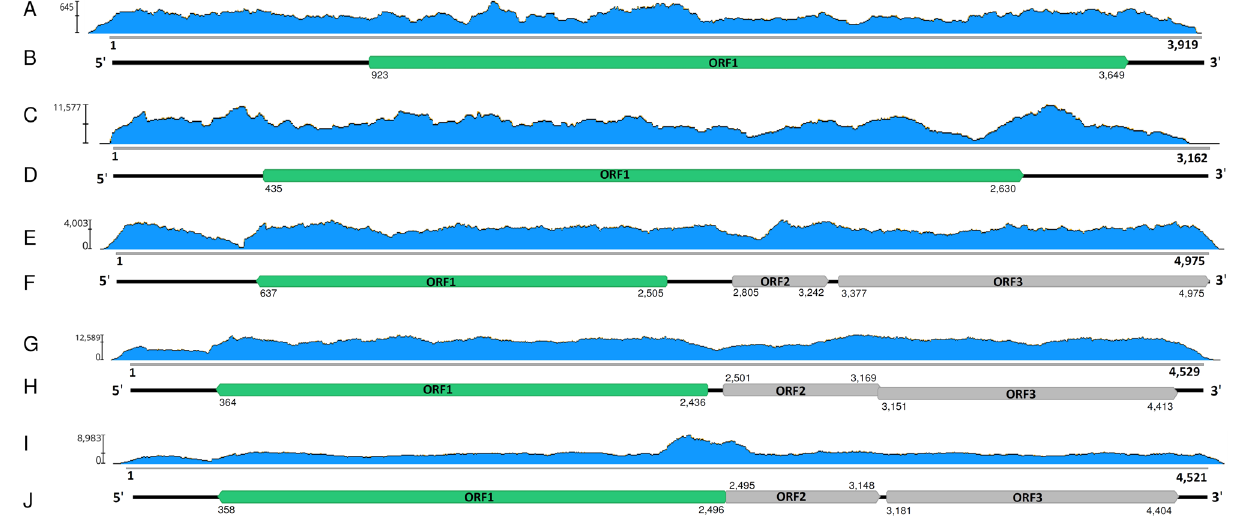
Figure 4. Genome organization of the Armillaria ourmia-like and ambi-like viruses. ( A ) Coverage of raw reads mapped against the Armillaria mellea ourmia-like virus 1 (AmOlV1) genome. ( B ) Schematic presentation of AmOlV1 genome with UTRs and predicted ORFs. ( C ) Coverage of raw reads mapped against the Armillaria mellea ourmia-like virus 2 (AmOlV2) genome. ( D ) Schematic presentation of AmOlV2 genome with UTRs and predicted ORFs. ( E ) Coverage of raw reads mapped against the Armillaria borealis ambi-like virus 1 (AbAlV1) genome hosted by isolate N40. ( F ) Schematic presentation of AbAlV1 genome with UTRs and predicted ORFs. ( G ) Coverage of raw reads mapped against the Armillaria borealis ambi-like virus 2 (AbAlV2) genome hosted by isolate N40. ( H ) Schematic presentation of AbAlV2 genome with UTRs and predicted ORFs. ( I ) Coverage of raw reads mapped against the Armillaria sp. ambi-like virus 3 (AsAlV3) genome hosted by isolate N40. ( J ) Schematic presentation of AsAlV3 genome with UTRs and predicted ORFs. Predicted translation initiation and termination sites are marked above or below each ORF. Predicted RdRPs coloured with green